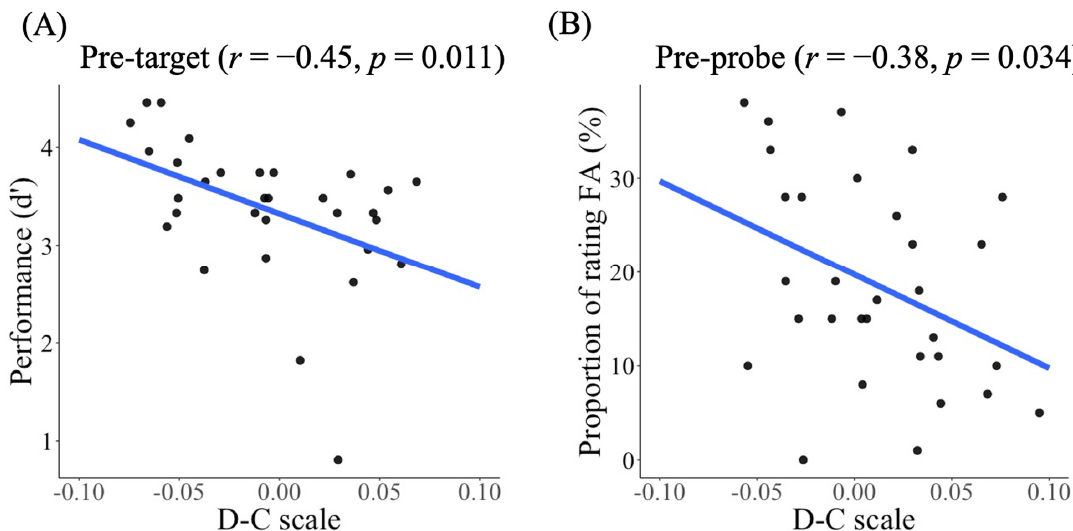
Figure 4. The correlations between ( A ) the performance ( d’ ) and the D-C scale during the pre-target phase ( B ) the propor- tion of rating focused attention (FA) and the D-C scale during the pre-probe phase.